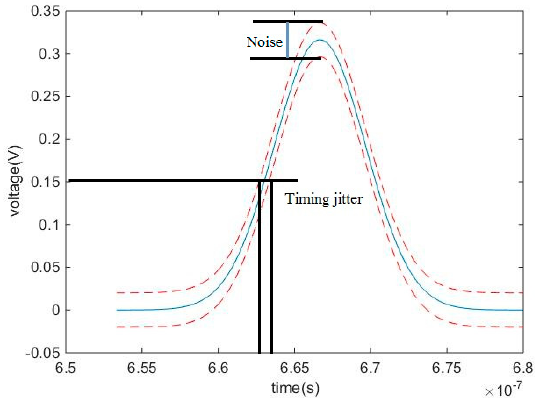
Figure 4. Definition of TJ caused by noise as statistical fluctuations existing in the shape of the detected pulses.